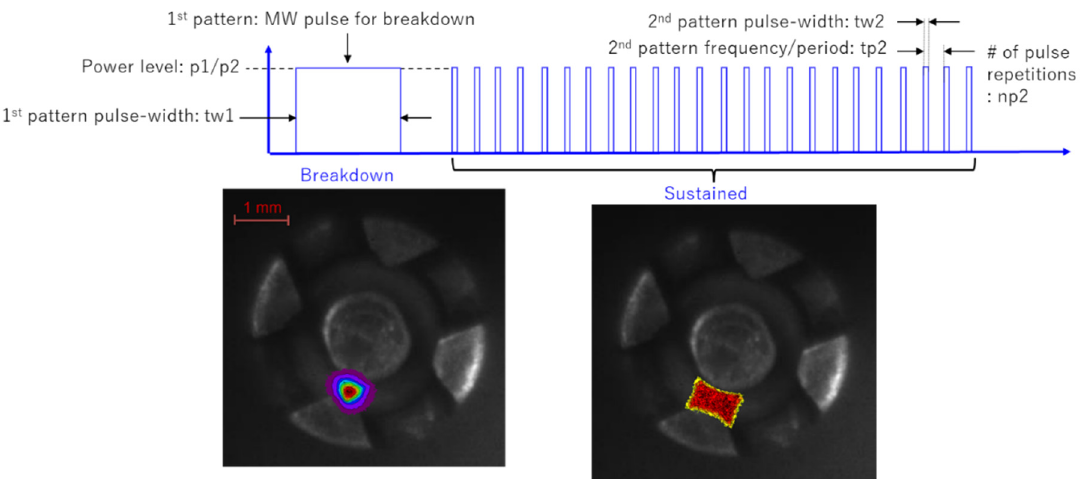
Figure 9. Oscillation pattern of microwave input of microwave discharge igniter (MDI) initiates plasma breakdown and sustains ignition for a long period [30].